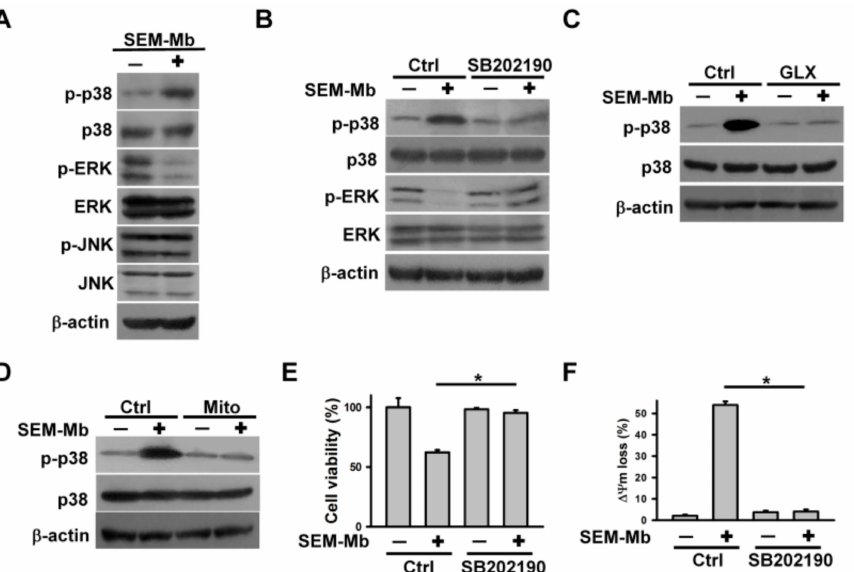
Figure 3. SEM-Mb triggered p38 MAPK phosphorylation by increasing mitochondrial ROS pro- duction. U937 cells were directly treated with 1.5 µ M SEM-Mb for 24 h or pre-treated with 10 µ M GLX351322, 10 µ M Mito-TEMPO, or 10 µ M SB202190 for 1 h and then incubated with 1.5 µ M